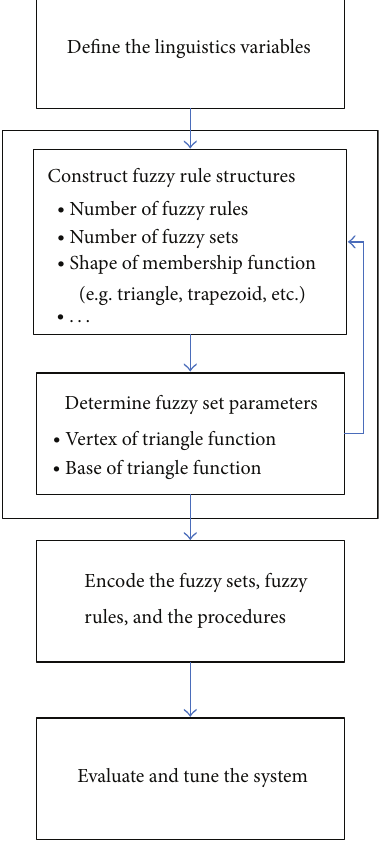
Figure 2: Procedure of developing the fuzzy system.